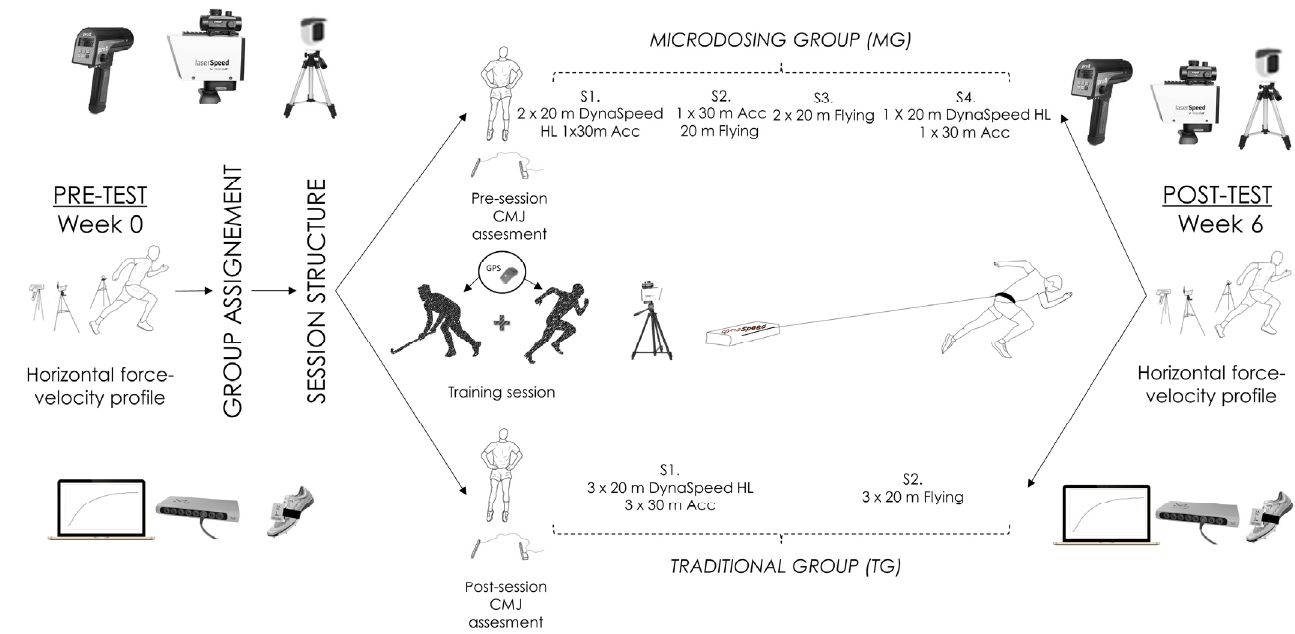
Figure 1. Experimental design and testing structure: T20m: time in 20 m sprint test; HFVP: horizontal force–velocity profile; S: Sessions; CMJ: counter movement jump; Dynaspeed; Acc: accelerations; GPS: global positioning system; W: week; HL: Heavy Load.